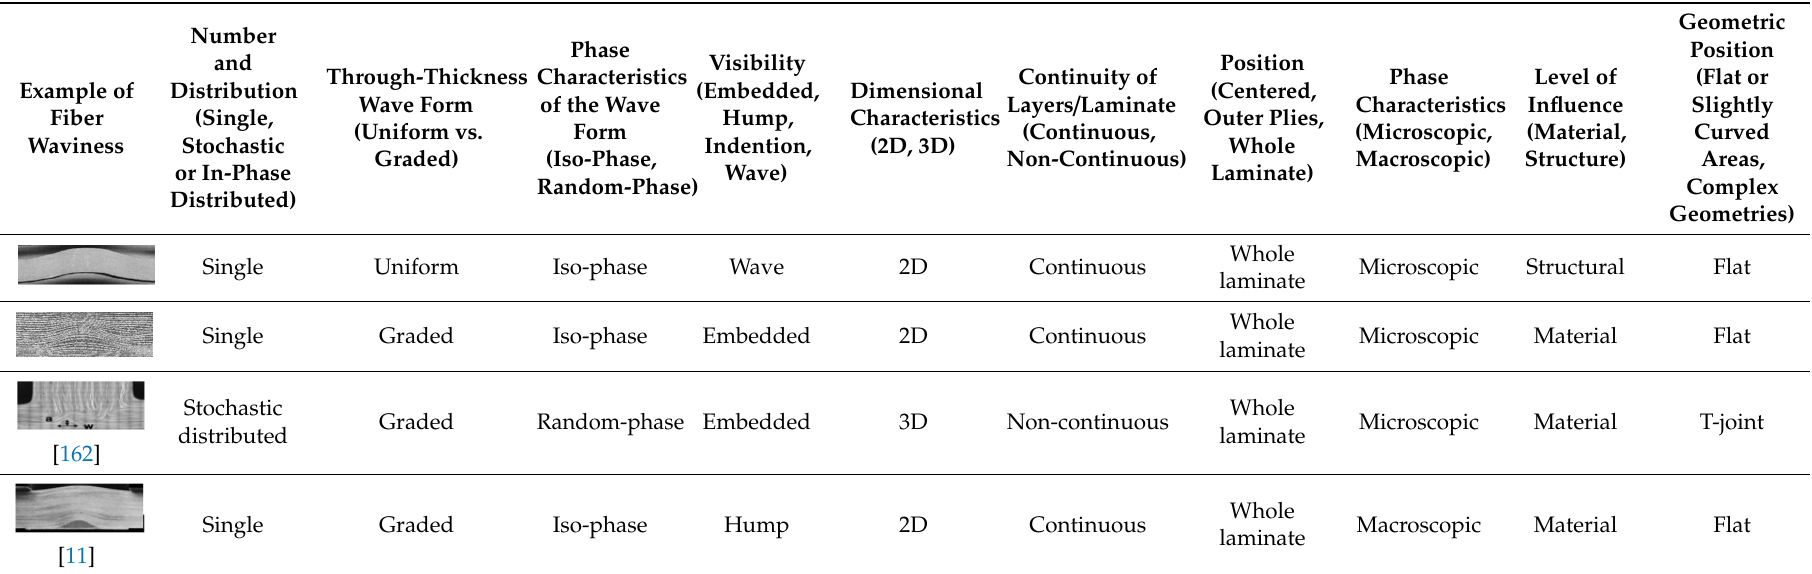
Table 3. Examples for waviness classification.